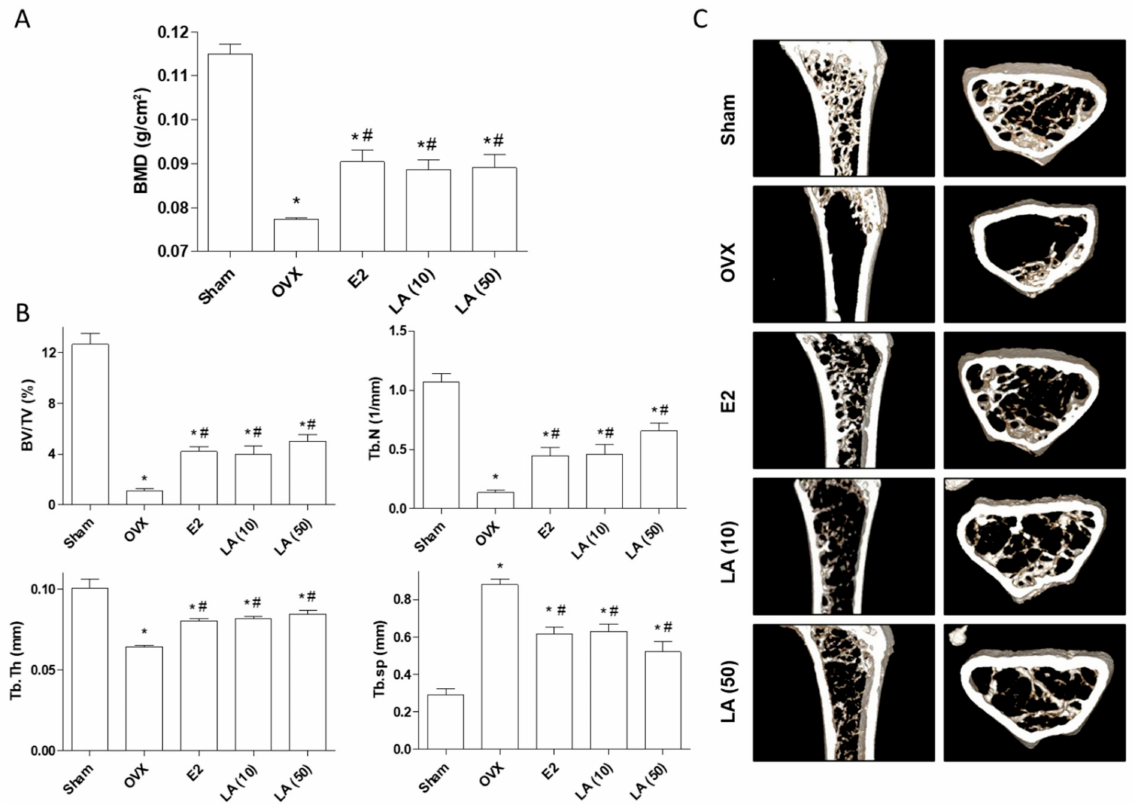
Figure 7. Effects of loganic acid on an OVX-induced osteoporosis murine model. Mice were administered either 17 β - estradiol (E2) or loganic acid (10 or 50 mg/kg/day) for 12 weeks. Sham: sham operated, OVX: ovariectomized mice, LA: loganic acid. ( A ) Bone mineral density of the right femoral bone was evaluated by PIXI-mus bone densitometer after 12 weeks. ( B ) Bone volume (BV/TV), trabecular thickness (Tb.Th), number (Tb.N), and spacing (Tb.Sp) were measured after 12 weeks. ( C ) Micro-CT images of the right femoral bone were scanned by microcomputed tomography. * p < 0.05 vs. Sham, # p < 0.05 vs. OVX (ANOVA with Tukey’s honest significant difference post hoc